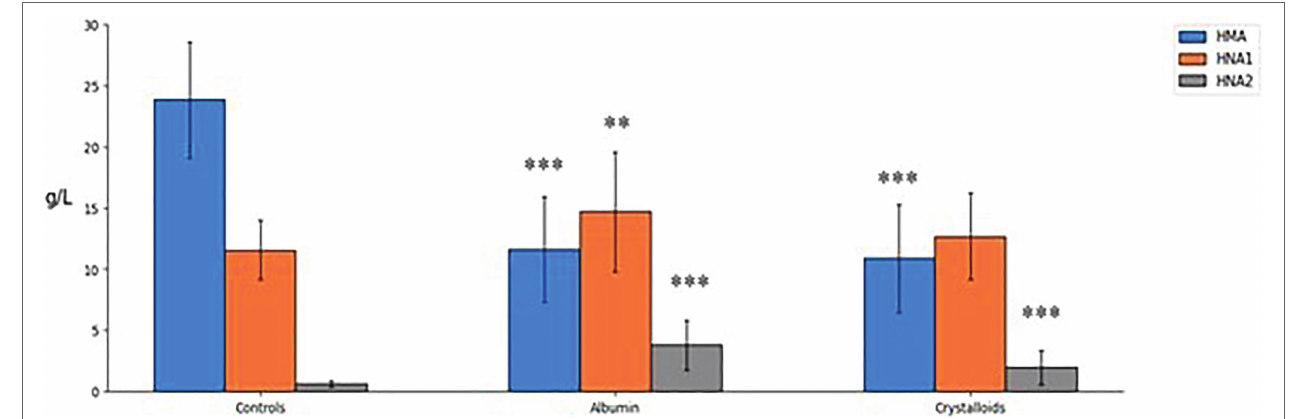
FIGURE 1 | Albumin forms concentration (g/L) in 21 healthy age-matched controls and 60 septic patients on day 1. Mean ± SD, p for treated patients, either albumin or crystalloids vs. healthy control groups (one-way ANOVA): ** p < 0.01 and *** p < 0.001. HMA, human mercaptoalbumin; HNA1, reversibly oxidized human non-mercaptoalbumin; and HNA2, irreversibly oxidized human non-mercaptoalbumin.